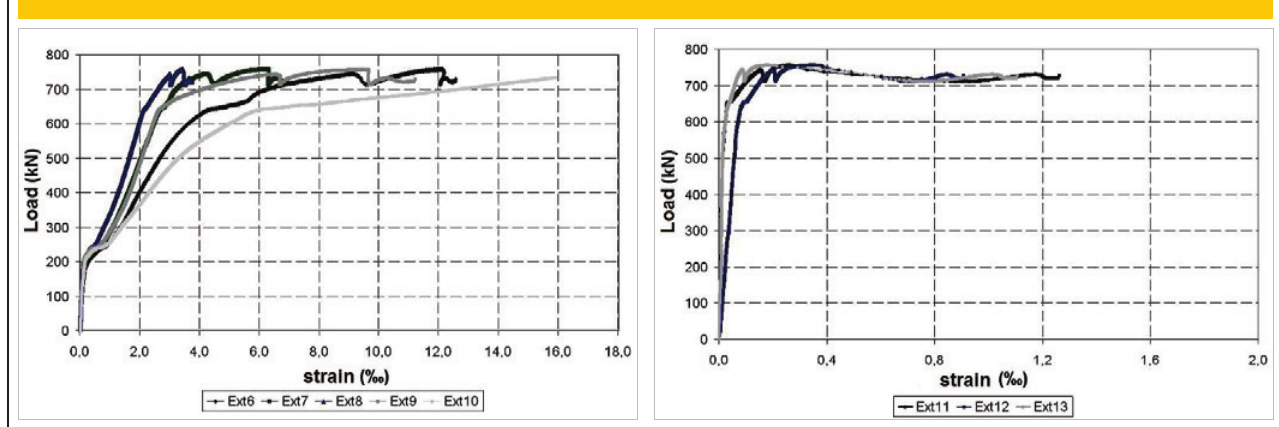
Figure 9 – Load-strain curve on reinforcement bars positioned in central region and over piles